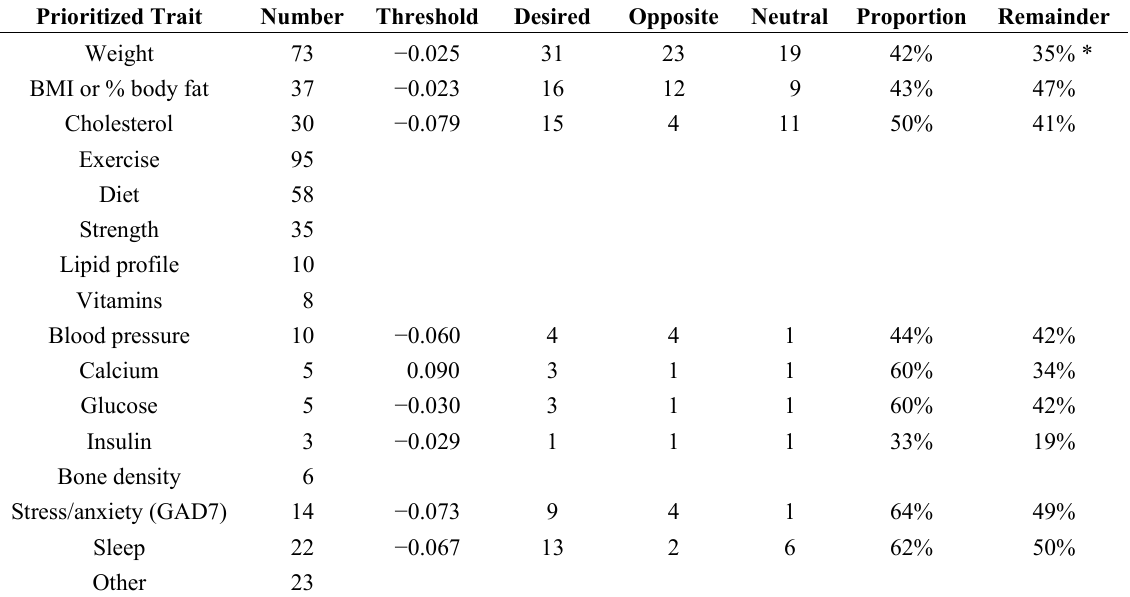
Table 3. Targeted Health Responses in 162